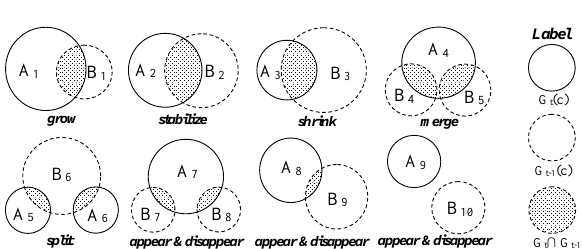
Figure 6: Intersection cases of the UHI G t ( c ) in two consecutive time instants Behaviors shown in Figure 2 are identified for each time instant. Movements are computed based on the displacement and area variation as shown in Figure 6. If there is no intersection between two consecutive UHI polygons, it is reasonable to consider they have no relationship. If two polygons overlap on a sufficiently big area, they are considered to be two representations of the same UHI at two consecutive time instants. Hence changes at time t i are more specifically defined as